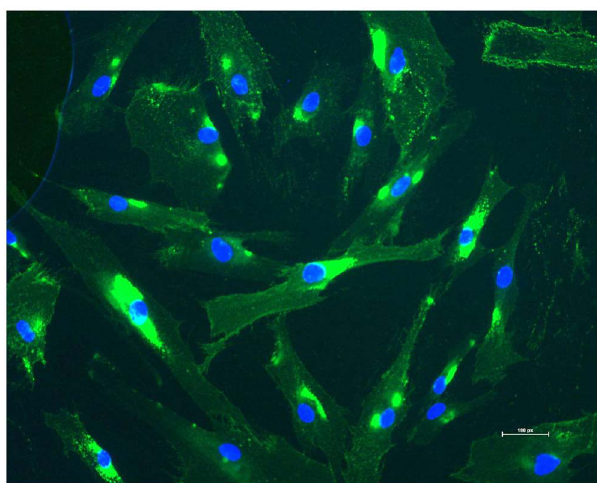
Figure 1. Assessment of the purity of fibroblasts from a cultured skin biopsy. Fibroblast surface protein (FSP) was used as a marker in immunofluorescence of the cultured fibroblasts obtained directly obtained from the skin biopsy. The green represents fibroblasts and the nucleus was stained with Hoechst-dye 33342 which shows blue.